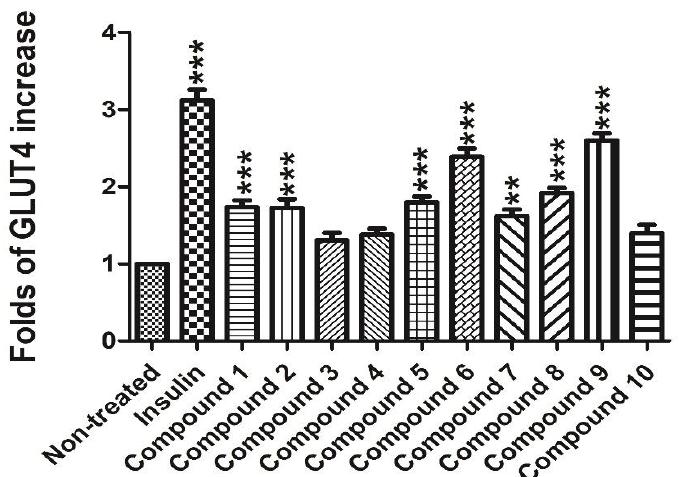
Figure 5. Experimental and calculated ECD spectra of compound 3 .